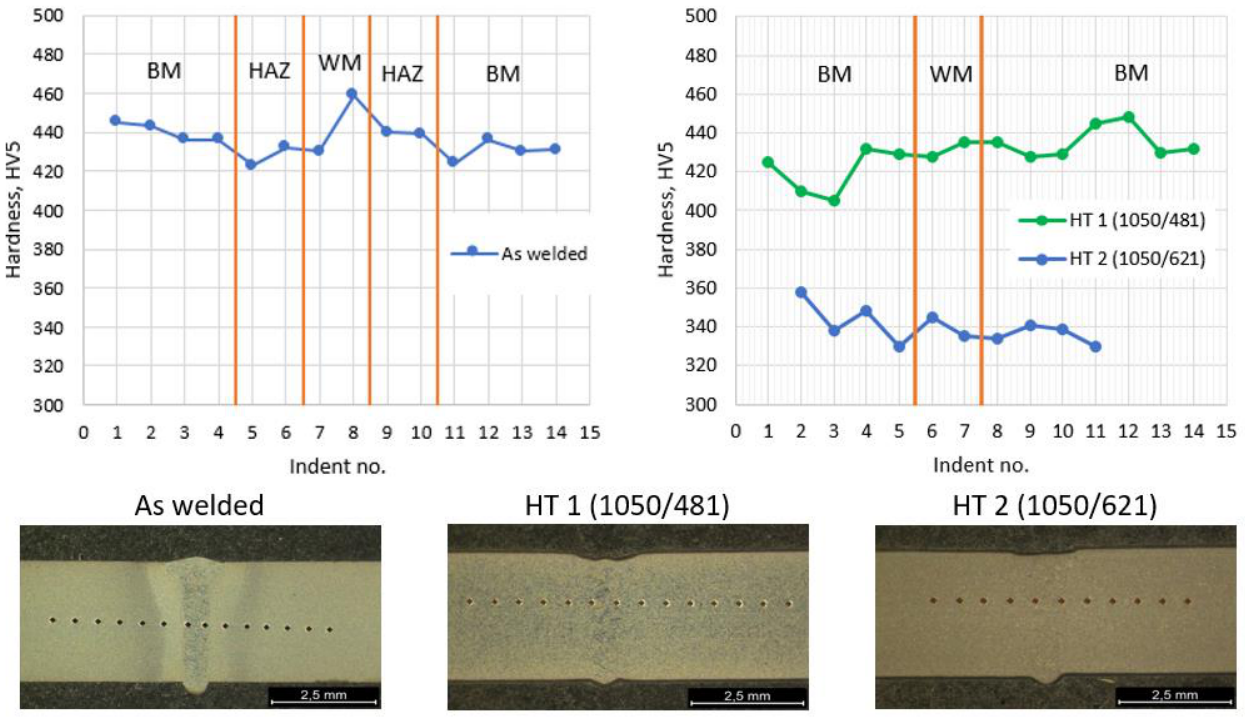
Figure 4. The Vickers hardness distribution in the cross-section for the conditions of the as-welded and after heat treatment with the indent placement.